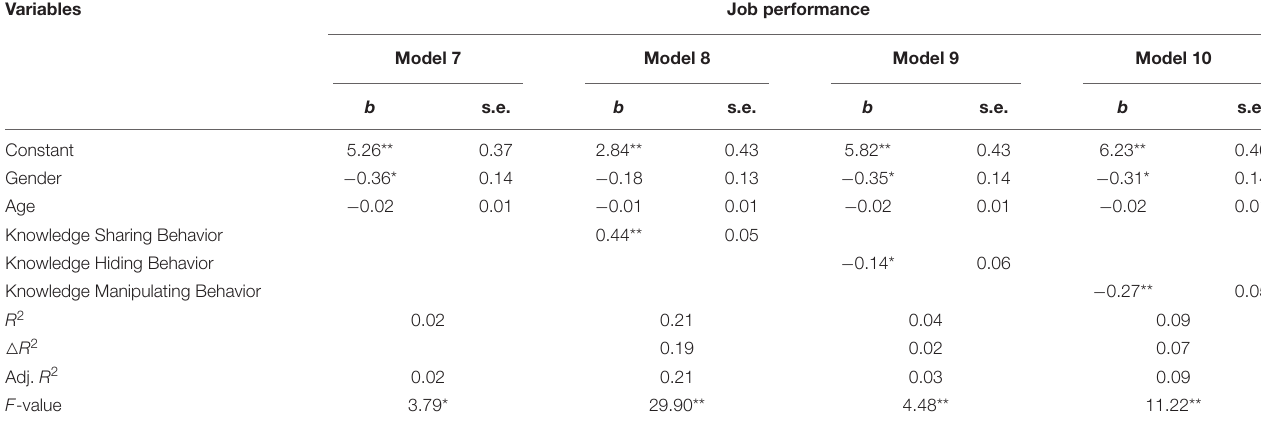
TABLE 3 | Results of hierarchical linear regression analysis for hypothesis 4, 5, and